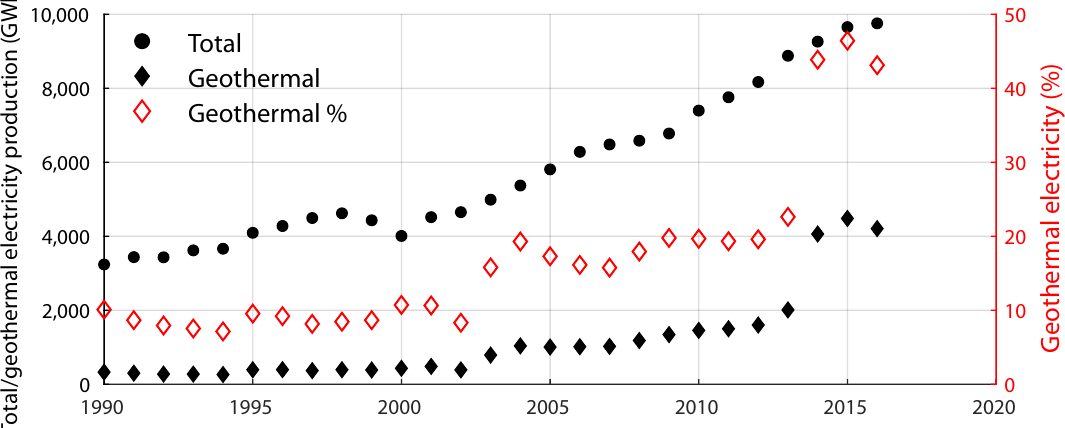
Figure 1. Evolution of electricity production and geothermal share in production for the period 1990–2015 for Kenya